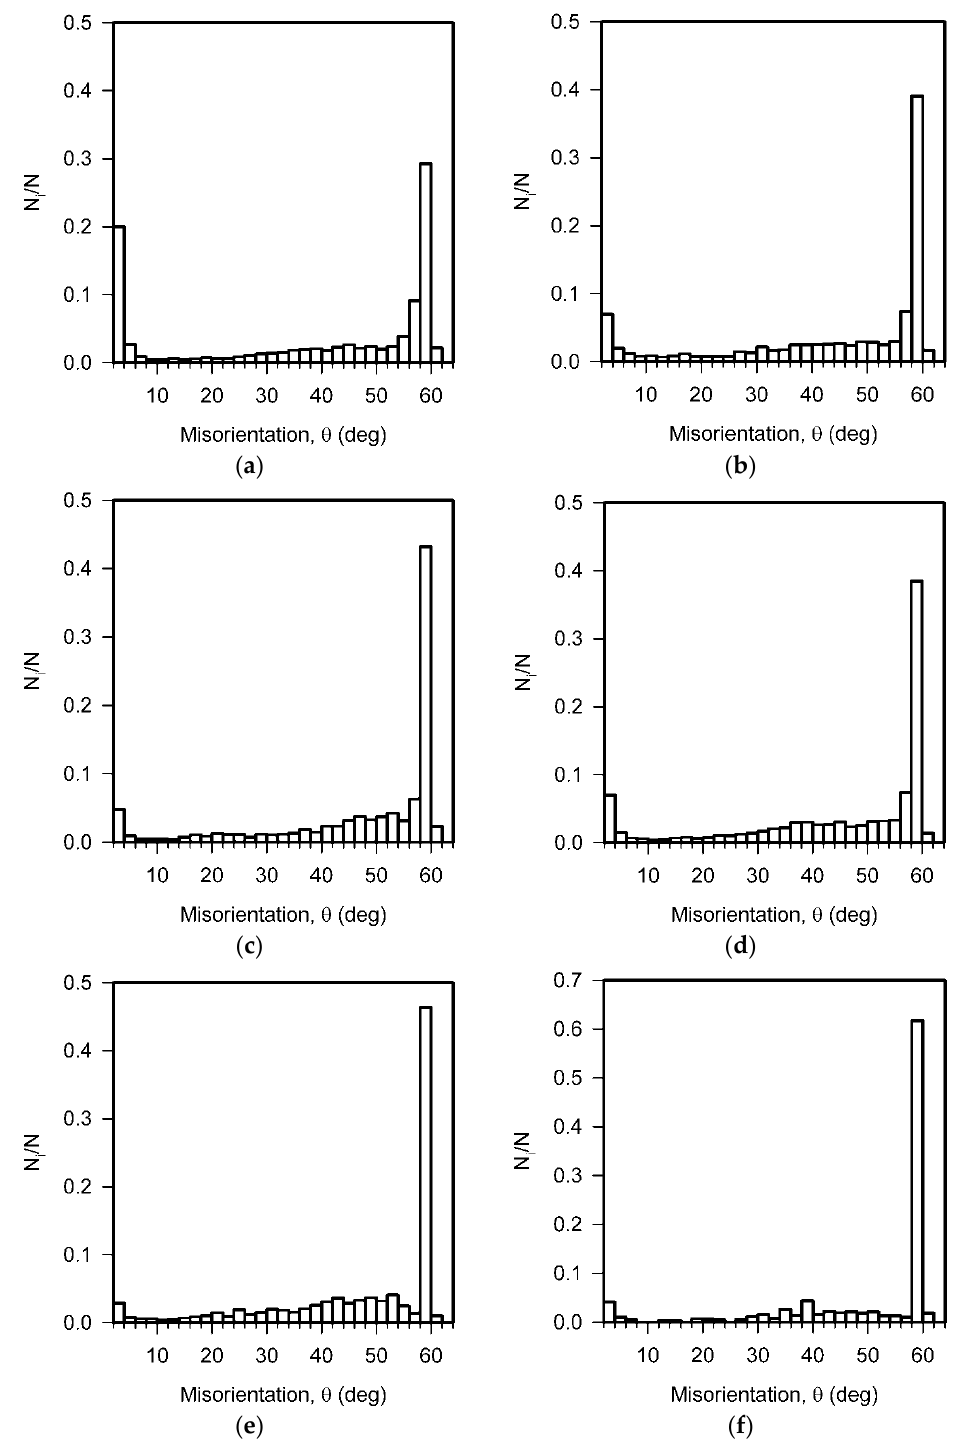
Figure 3. Grain boundary misorientation distribution in the steel samples subjected to cold rolling with 5% reduction ( a ), and then annealed for 1 h at 700 °C ( b ), 800 °C ( c ), 900 °C ( d ), 1000 °C ( e ), and 1100 °C ( f ).